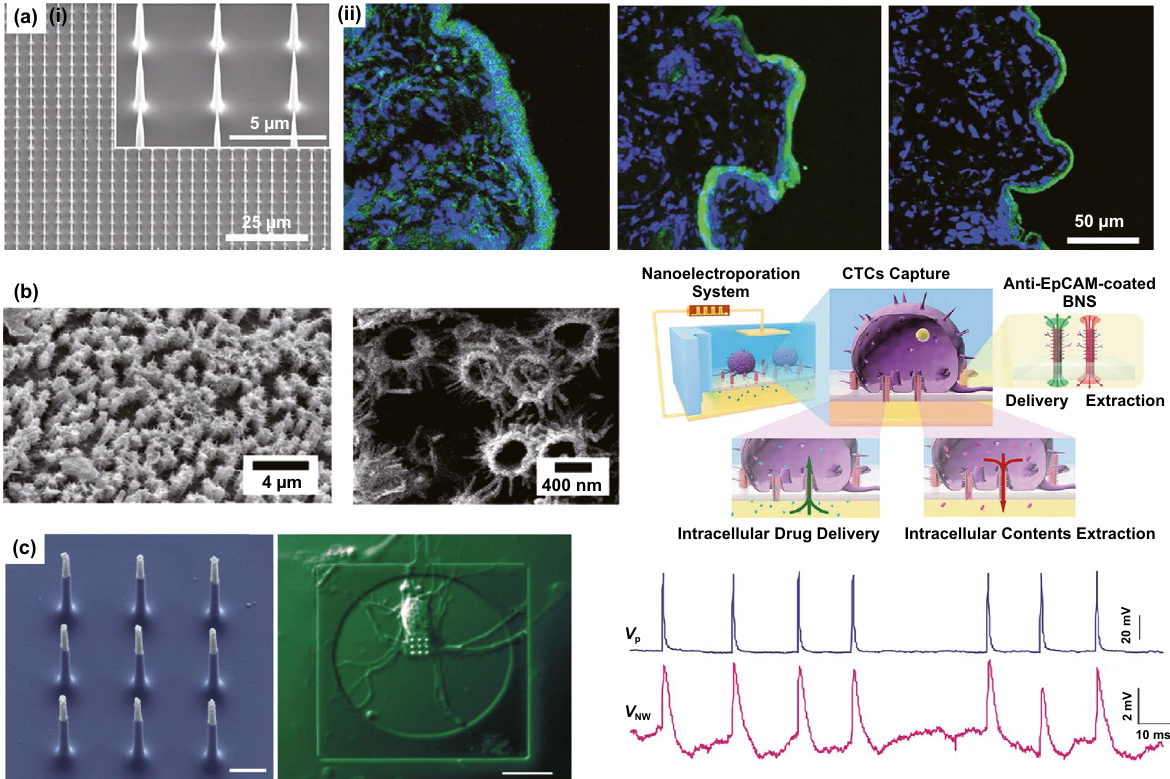
Fig. 2 a (i) SEM image of the silicon nanowire array. (ii) Fluorescent images showing tissue sections of nanowire arrays + TENG, Flat + TENG and nanowire arrays after treatment with 10 kD dextran‑ FITC delivery [98]. b SEM images of the BNS array, and schematic diagram of cell delivery and extraction in situ after capture of cancer cells by an electroporation system constructed with BNS array [84]. c SEM images of the VNEA and DIC micrographs of rat cortical neurons after incubation on them. Action potentials were stimulated with a patch pipette (blue), and also recorded by the VNEA pad in Faradaic mode (magenta) [101]. Reproduced with permission from Refs. [84, 98, 101], copyright (2019) American Chemical Society Publishing Group (2019) Wiley‑VCH Publishing Group and (2012) Nature Publishing